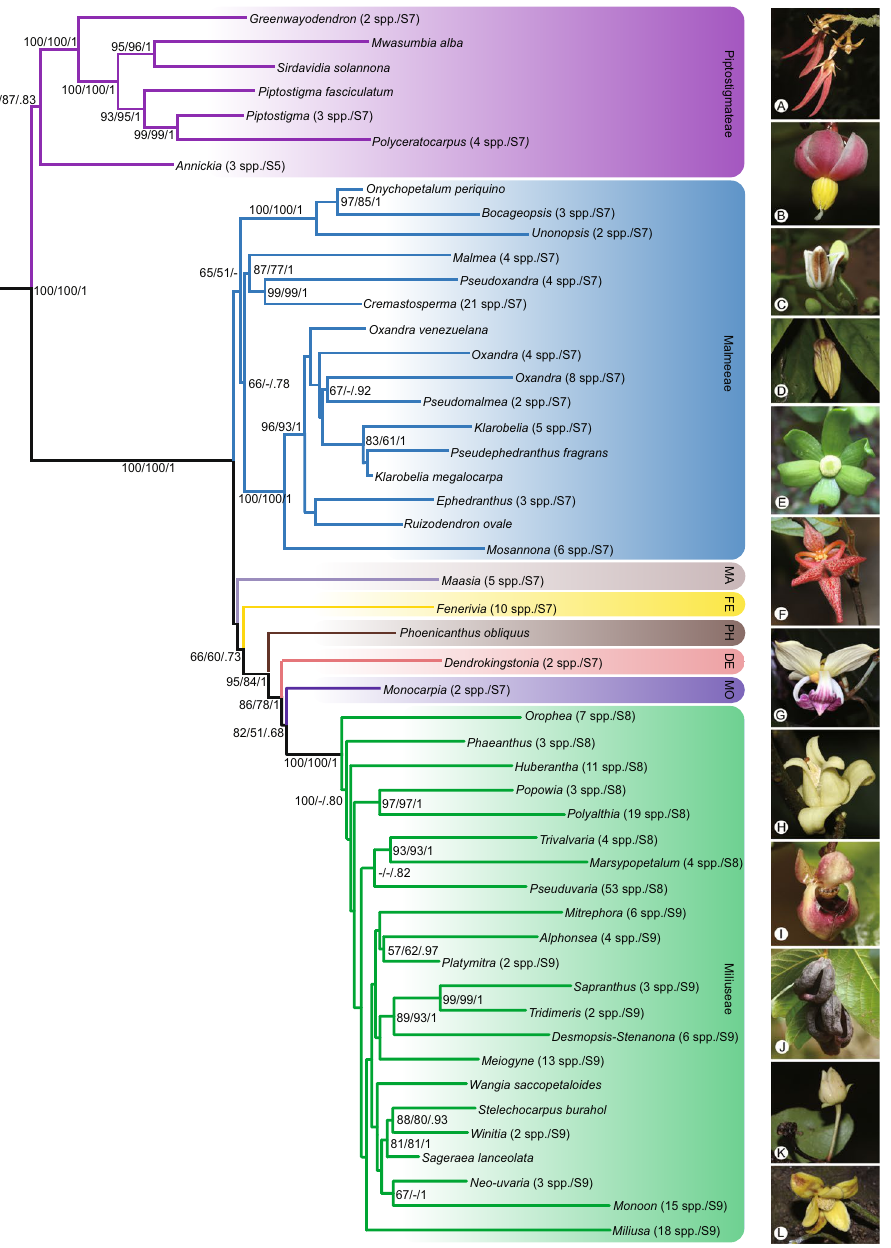
Figure 2. Skeletal representation of the best-scoring maximum likelihood tree inferred from a 754-accession dataset of eight chloroplast markers, showing topology of Malmeoideae. Tips represent genera or subdivisions when genera are not monophyletic. Higher taxon names appear at right, marked with different background colours. ML bootstrap (BS) values ≥ 50, MP jackknife (JK) values ≥ 50 and Bayesian posterior probabilities (PP) values ≥ 0.5 are indicated at each node: BS /JK/ PP. -, represents clade support values < 50%. Numbers in brackets show numbers of sampled taxon and supplementary figures of each lineage. Tribe abbreviations: MA: Maasieae; FE: Fenerivieae; PH: Phoenicantheae; DE: Dendrokingstonieae; MO: Monocarpieae. Flower morphology of the selected genera: ( A ) Piptostigma multinervium ; ( B ) Sirdavidia solannona ; ( C ) Onychopetalum periquino ; ( D ) Phaeanthus ophthalmicus ; ( E ) Huberantha tanganyikensis ; ( F ) Orophea maculata ; ( G ) Mitrephora winitii ; ( H ) Alphosea javanica ; ( I ) Pseuduvaria froggattii ; ( J ) Meiogyne heteropetala ; ( K ) Polyalthia suberosa ; ( L ) Stelechocarpus burahol . — Photographs: A–C, E, Thomas L. P. Couvreur; F, Junhao Chen; D, G, H, L, Xing Guo; I, J, Chun Chiu Pang; K, Daniel C. Thomas. Photos available at the World Annonaceae website 64 : http://